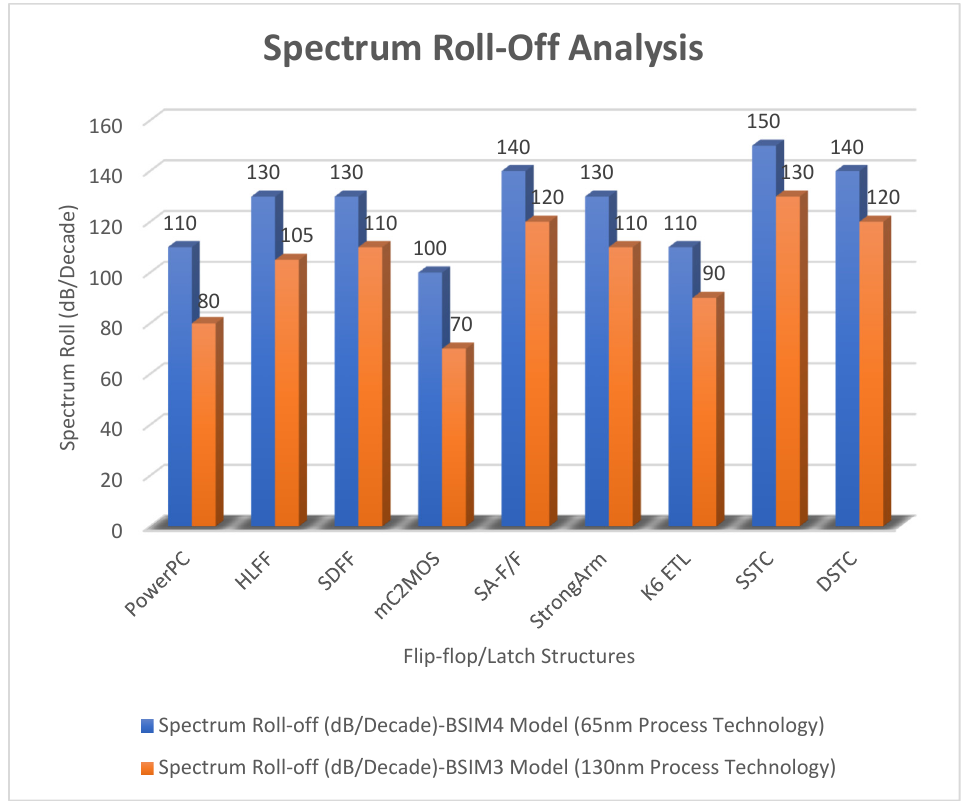
Figure 14. Spectrum roll-off analysis using 65 and 130 nm process design kits and arctan(sin) as the input signal.